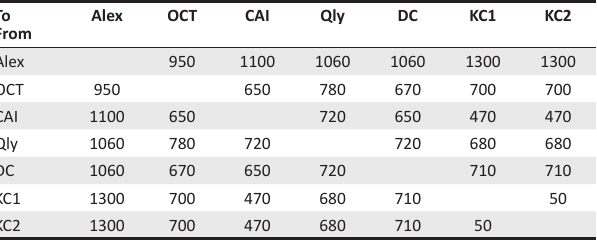
TABLE 2: Transportation cost matrix for trailer trucks. To From